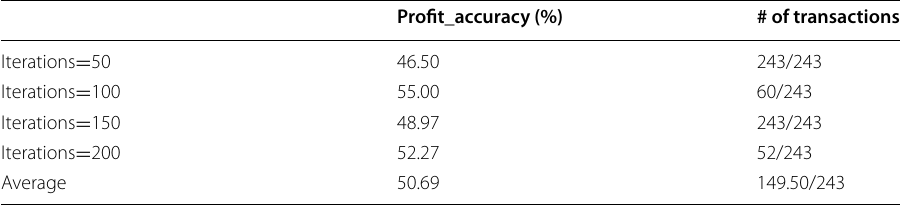
Table 4 ME_LSTM model: one‑day‑ahead result summary